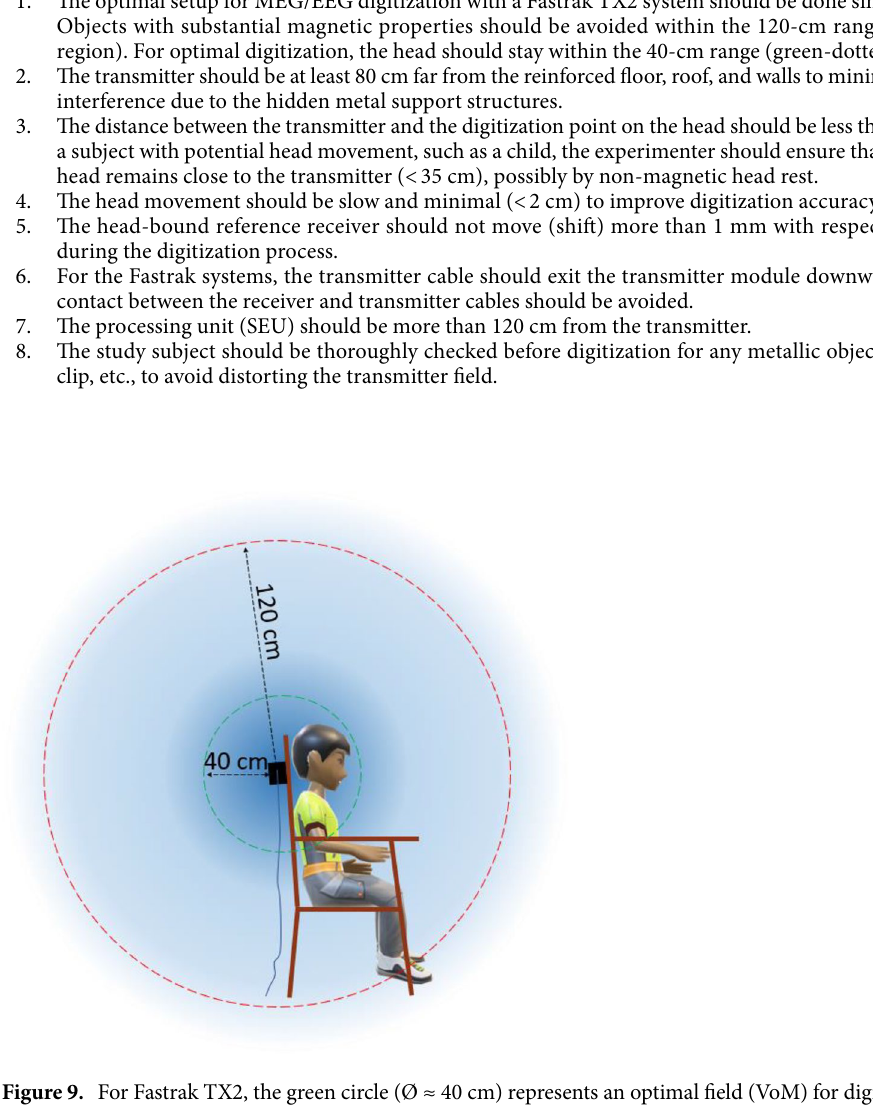
Figure 9. For Fastrak TX2, the green circle (Ø ≈ 40 cm) represents an optimal field (VoM) for digitization, and the red circle (Ø ≈ 120 cm) represents a boundary within which magnetic and conductive objects should be